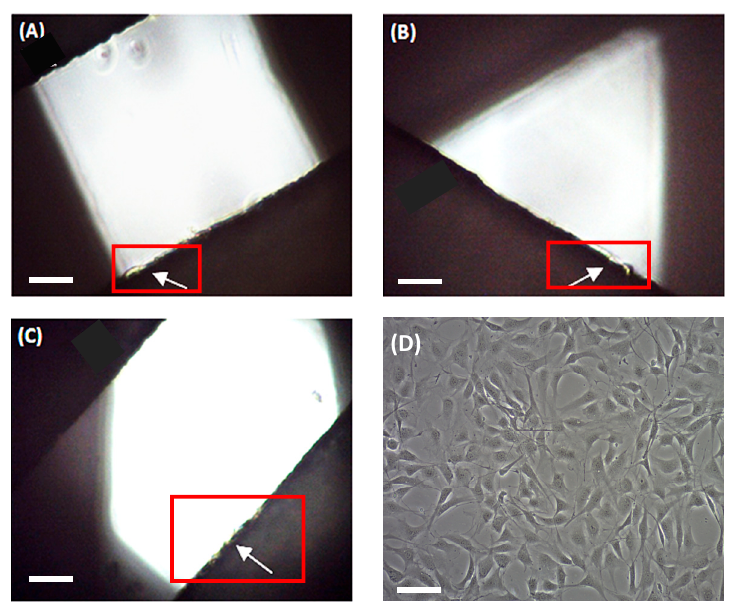
Figure 6. Optical microscope images of NIH/3T3 cells seeded on the scaffolds. Cells were attached on scaffolds of 90° ( A ), 60° ( B ), and 45° ( C ). ( D ) NIH/3T3 cells in a 2D culture. White arrows on the images indicate cells adhered to PCL filaments. Scale bars represent 100 µm.